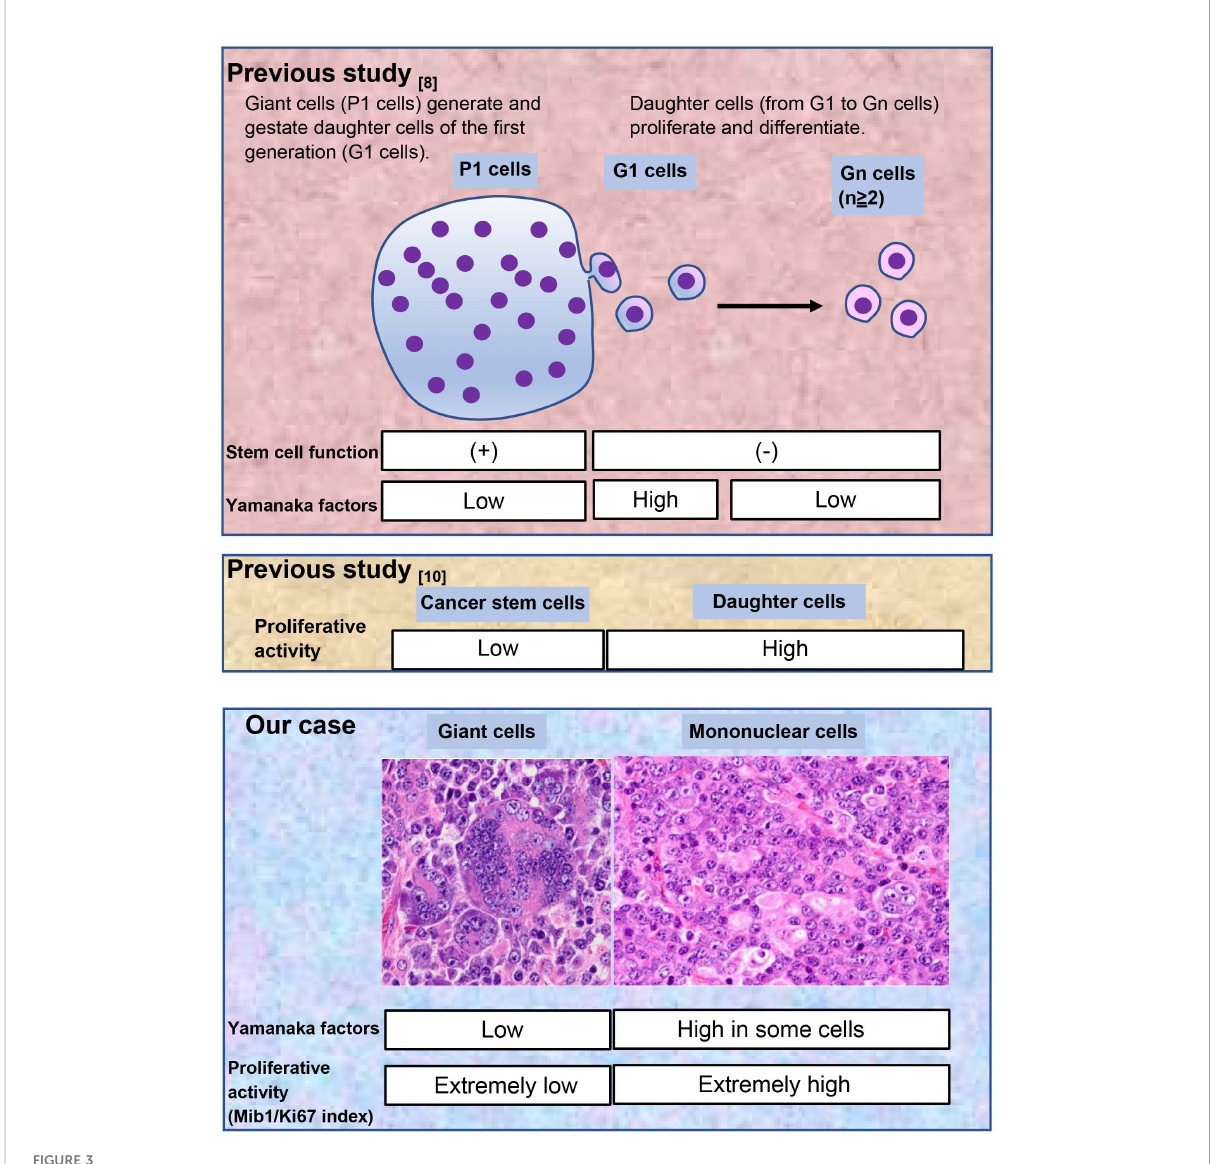
FIGURE 3 Comparison of our case with previous